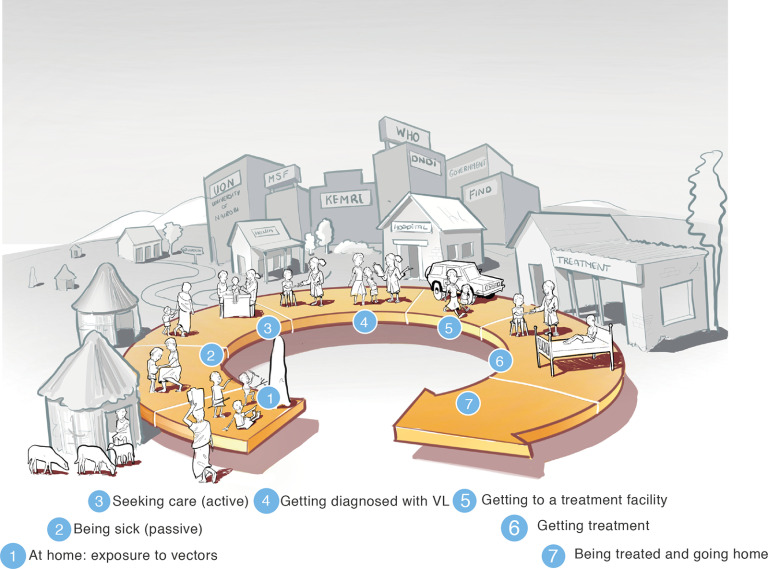
Gigamap Diagram Showing the Journey of a Patient Who Has Visceral Leishmaniasis From Infection to Treatment in Western Kenya and Northeastern UgandaAbbreviation: VL, visceral leishmaniasis.